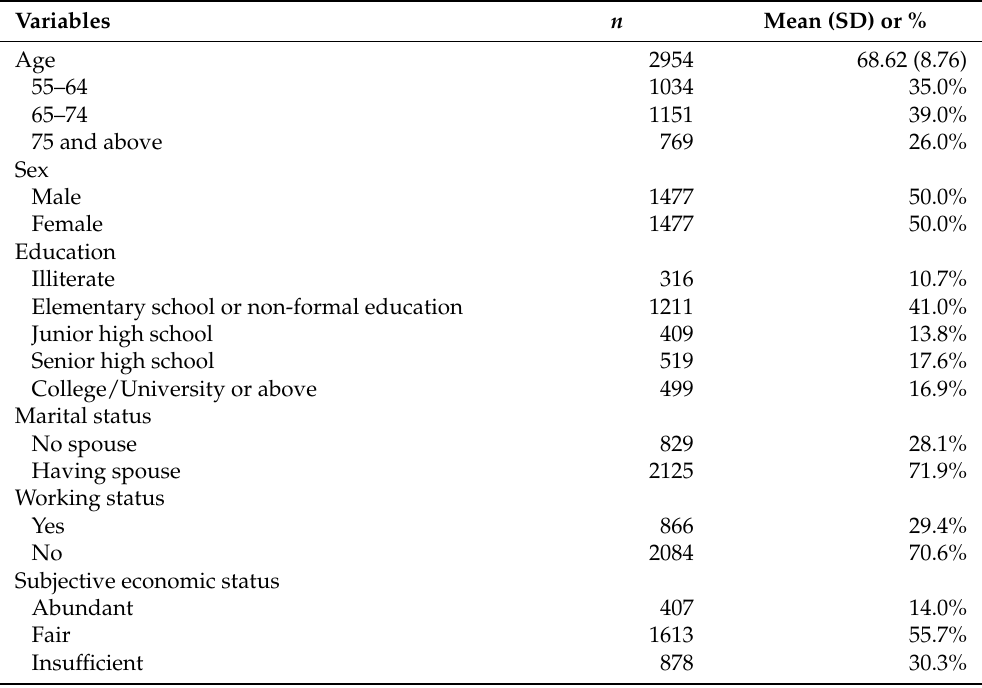
Table 1. The description of the sample demographics, health-related behaviors, health conditions, and dietary